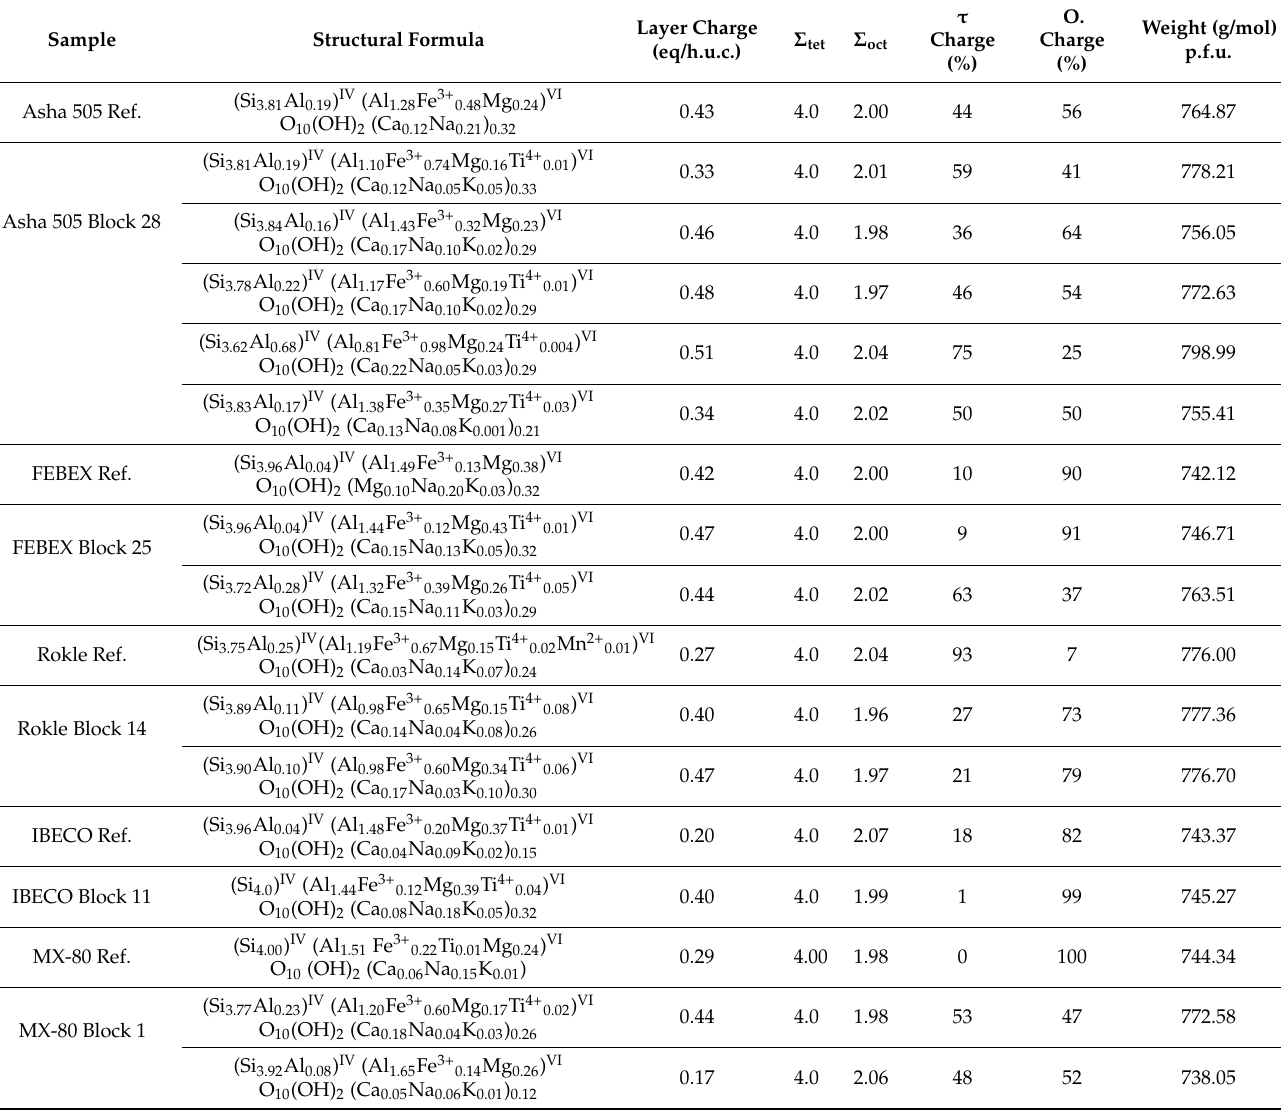
Table 5. Structural formula of clay particles analysed in reference samples and close to the heater contact (h.u.c: half unit cell, p.f.u: per full unit cell, τ charge: tetrahedral charge, O. charge: octahedral